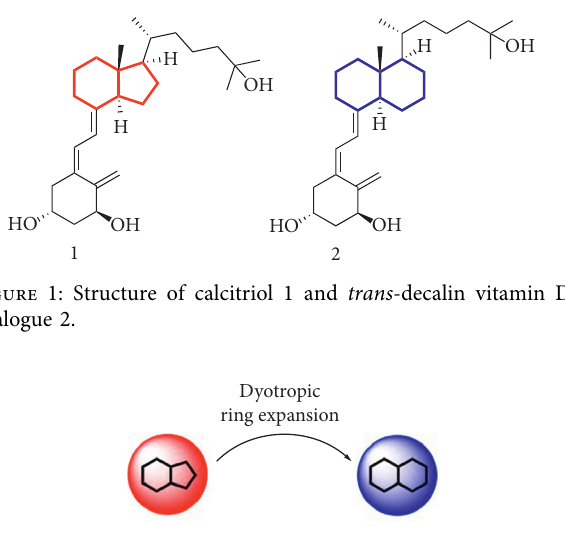
Scheme 3: Retrosynthetic scheme for the obtention of a new trans -